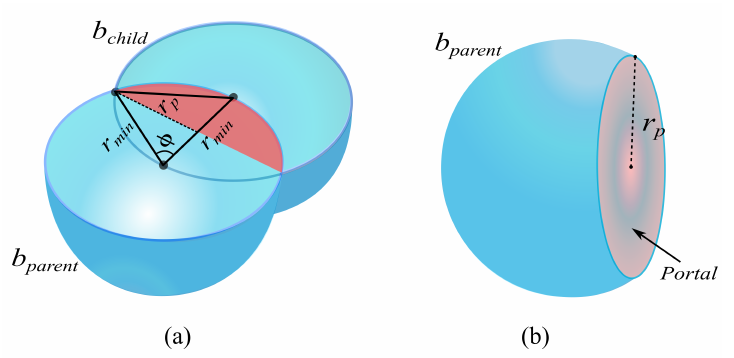
Figure 3. ( a ) Triangle formed between two overlapped bubbles b parent and b child with radius r min . The red region represents the hyperspherical cap. ( b ) Parent bubble and portal